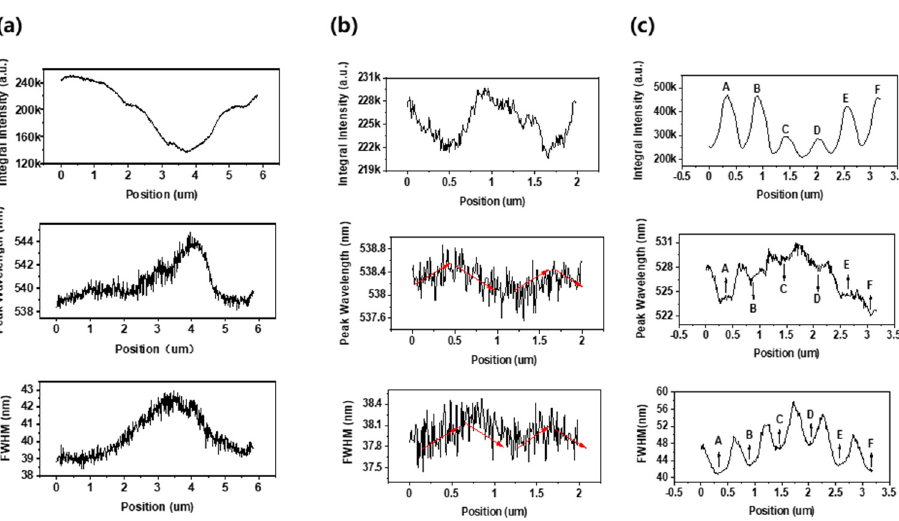
Figure 3. Integral intensity, peak wavelength, and FWHM of green emissions in CL line-scanning along: ( a ) red line 1 through dark region, ( b ) red line 2 through bright region in Figure 2a, ( c ) red line 3 though two dark nanorods in Figure 2b. Six nanorod centers are marked with the letters A–F.